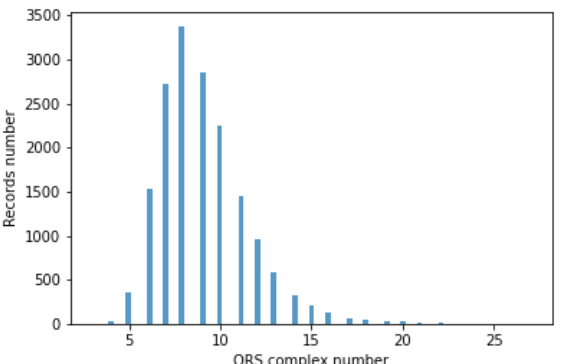
Figure 11. Histogram of the number of segments comprising the QRS